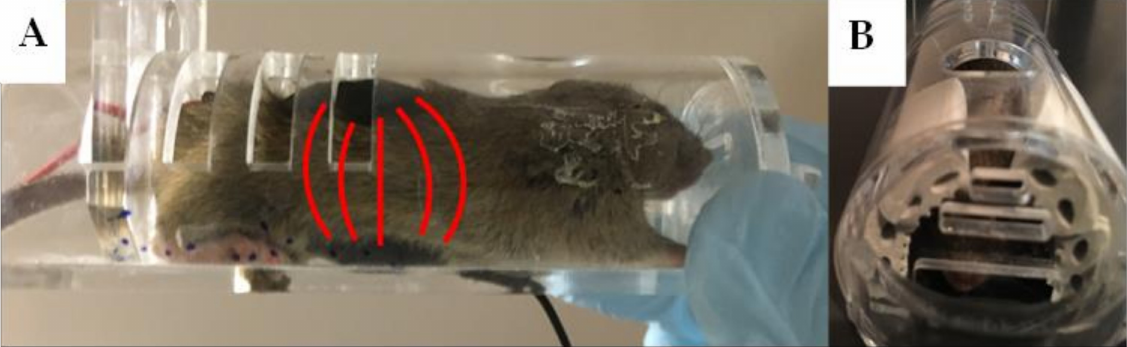
Figure 1. ( A ) Mounted saline-soaked sponge electrodes on mouse in plexiglass restrainer. tsDCS -induced electric field lines are illustrated by the red lines between the electrodes. ( B ) Foam added to restrainer to prevent access to electrode wires and calm